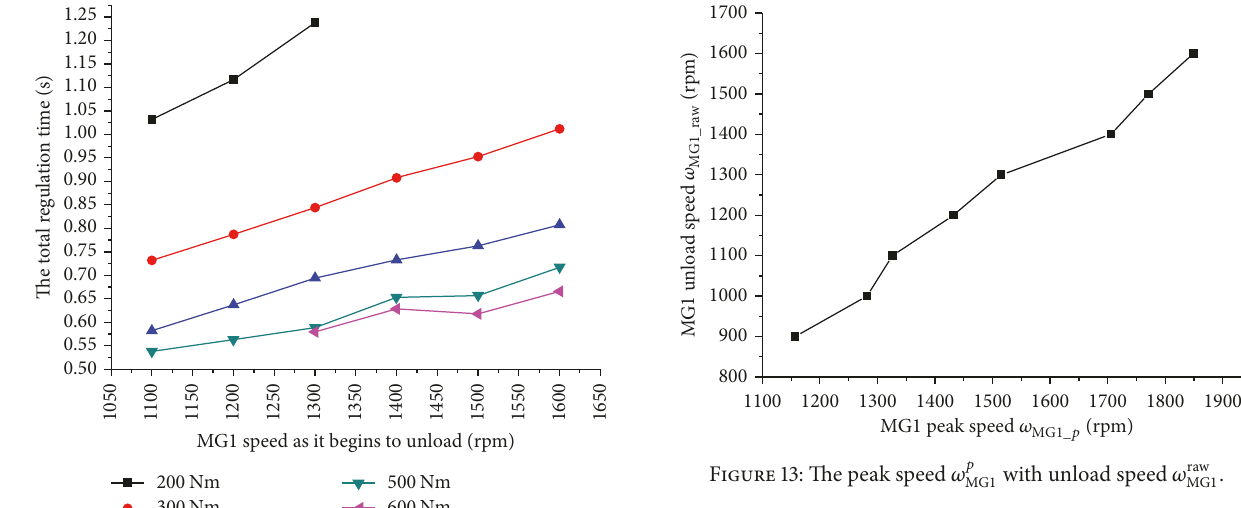
different 𝜔 raw MG 1 . A one-dimensional map was made on basis of the data. 𝜔 raw MG 1 can be gained by the known 𝜔 up the map backwards. Taking the first upshift mode as an example, 𝑇 ∗ = 509 Nm; the map is shown in Figure